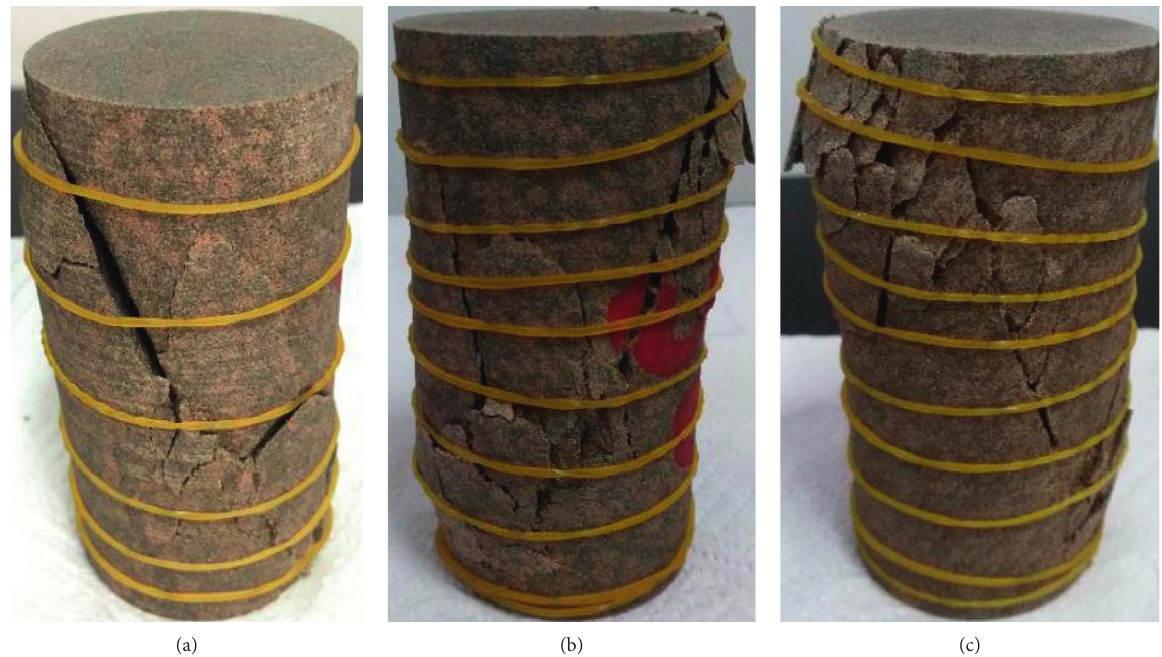
Figure 14: Macroscopic failure morphology of rock samples subjected to pH � 1 HCl for 90